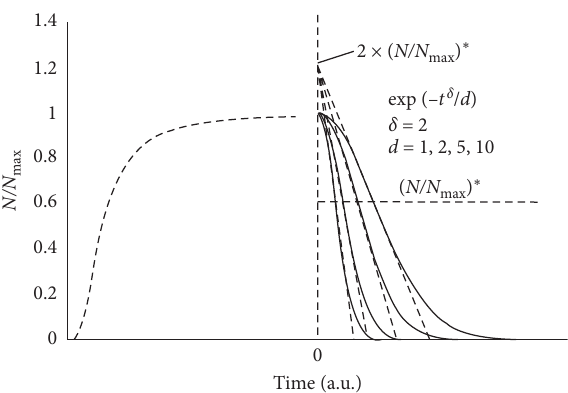
Figure 3: Escherichia coli at 10 ° C, pH 4 in the presence of 0.7% oregano essential oil. Plate count data after Skandamis and Nychas, as reported in [13].